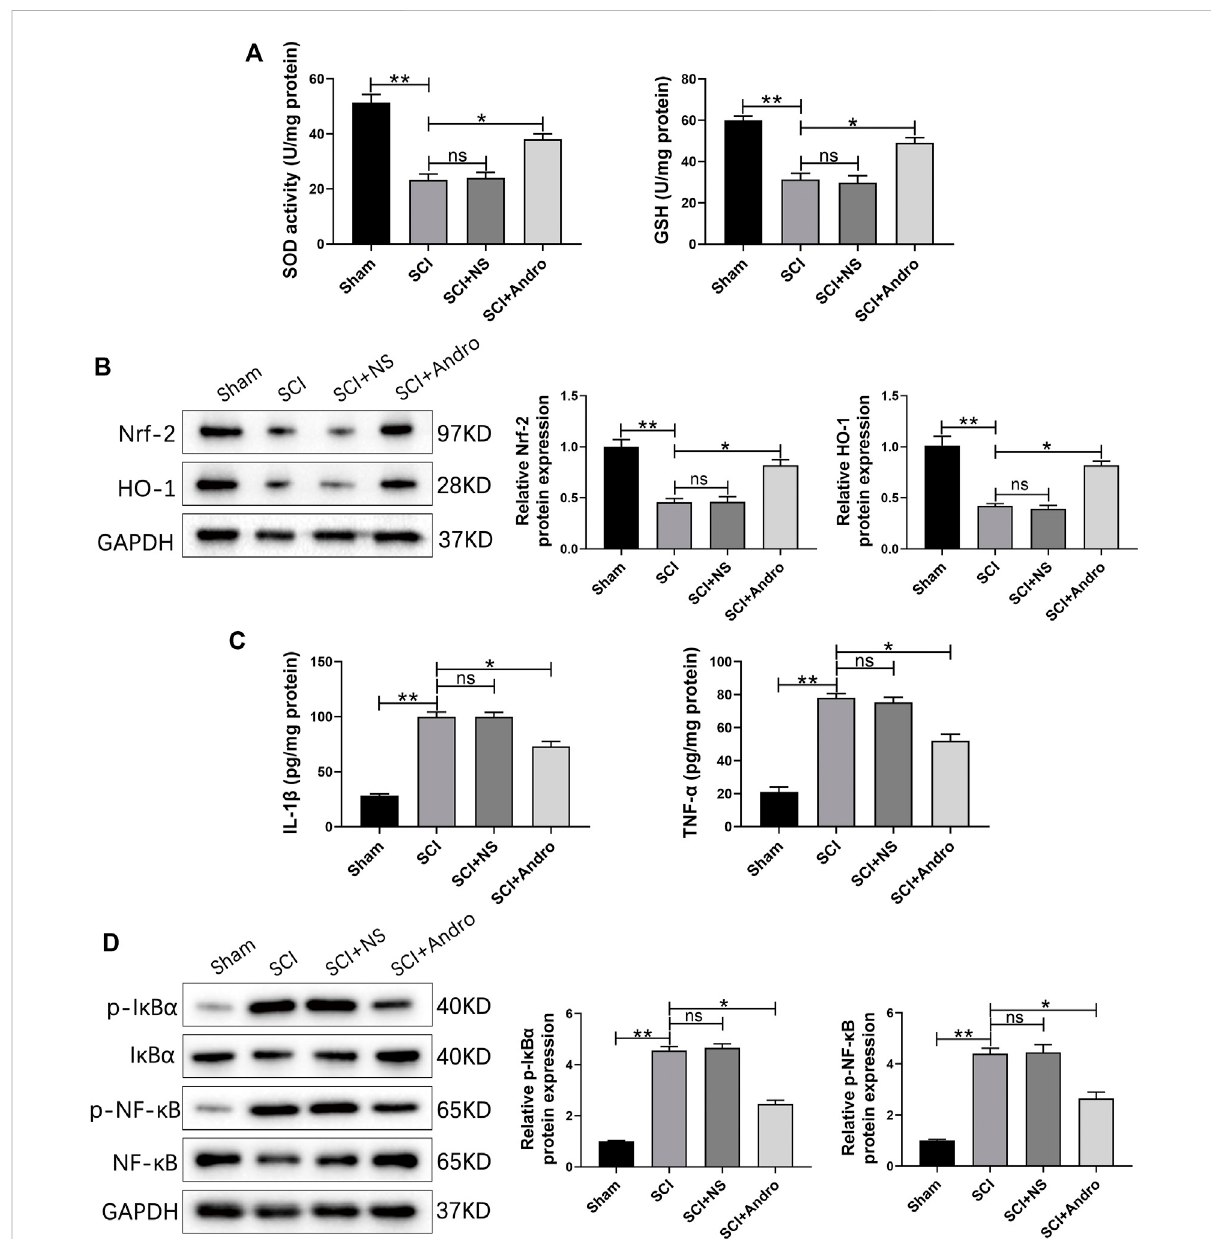
FIGURE 3 Andro treatmentreduced oxidativestress and in fl ammation of SCI rats. (A) SOD levels and GSH activity inthe indicated groups 7 days post-SCI. (B) Immunoblot and relative quanti fi cation of Nrf-2/HO-1 pathway-related proteins 7 days post-SCI. (C) IL-1 β and TNF- α levels at 28 days post-SCI. (D) Immunoblot and relative quanti fi cation of NF- κ B pathway-related proteins (p-I κ B α and p-NF- κ B) 28 days post-SCI. Data are presented as the mean ± SD, n = 3 per group.* p < 0.05,** p < 0.01, ns p ＞